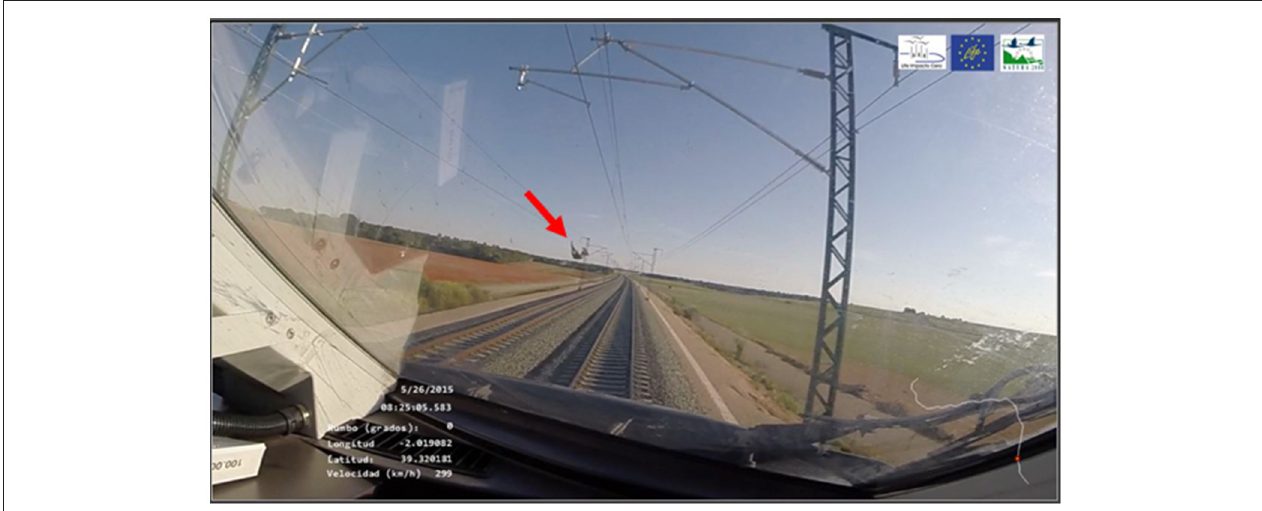
FIGURE 2 | Image capture of a recording from a train running at high speed. Lower left quadrant, in white, shows data inserted by the GPS system. Red arrow shows bird position moments before collision with the train.